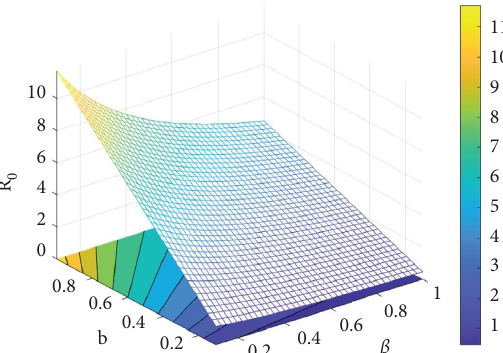
Figure 4: Te dynamics of sensitivity analysis with respect to parameters ω and b with R